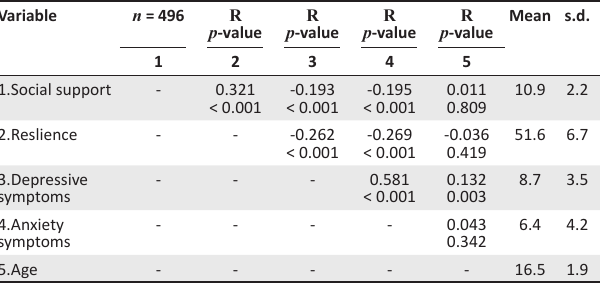
TABLE 4: Correlation matrix.